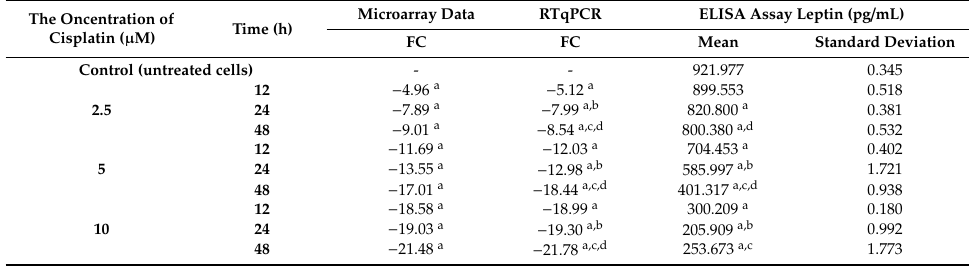
Table 1. Changes in the level of mRNA and the protein of leptin on both concentration and time exposure of the Ishikawa cell line to cisplatin.